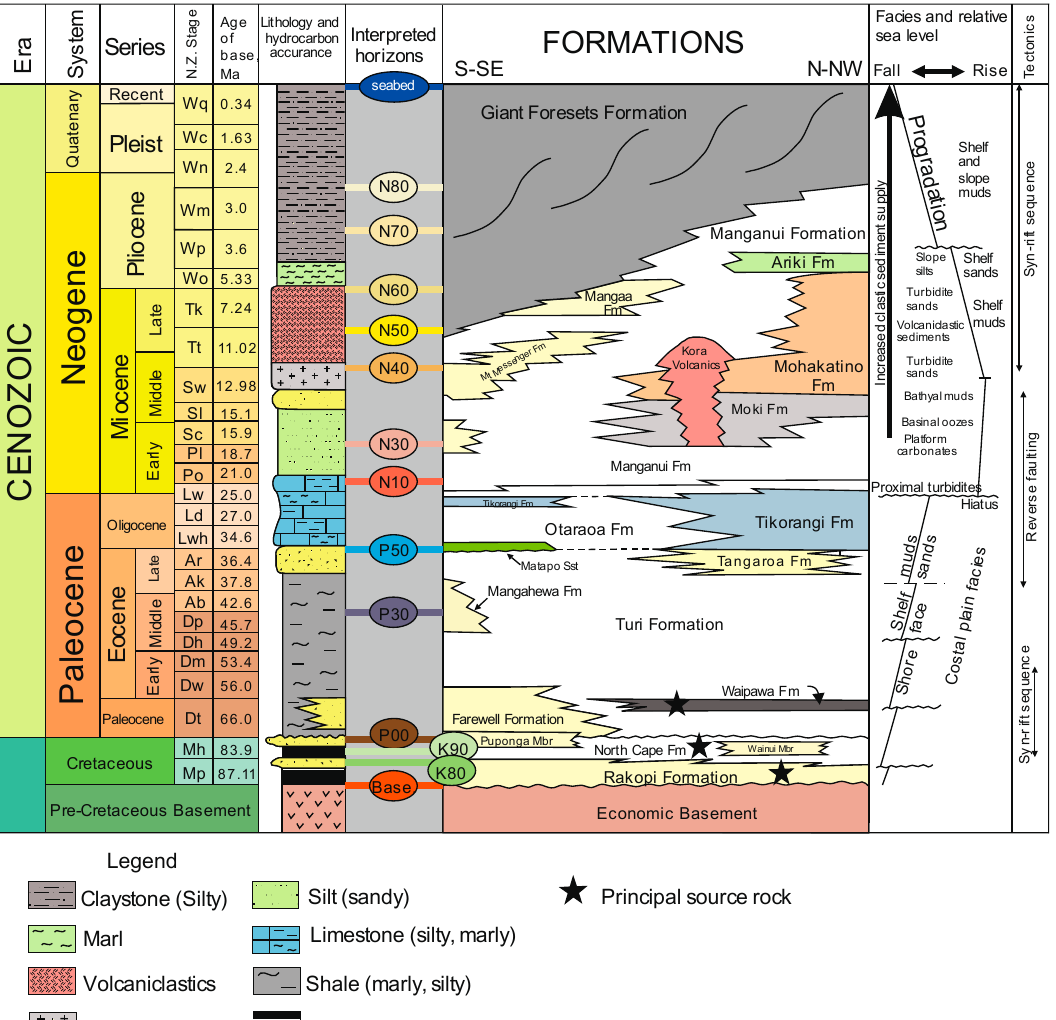
Figure 2. Cretaceous–Cenozoic stratigraphic framework for the northern Taranaki Basin and interpreted horizons from this study. Principal source rock in the area (Waipawa Formation) is marked with a star (modified after King and Trasher, [20]; Stagpoole and Funnel, [15]). Not to scale. The interpreted horizons above Cretaceous and older basement (Base), are the Late Cretaceous (horizons K80 and K90), Cretaceous-Paleogene (horizons P00–P50), Paleocene-Eocene (horizon P10), Eocene (horizon P30), Eocene-Oligocene (horizon P50), Early Miocene (horizon N10), Middle to Late Miocene (horizon N40), Base Pliocene (horizon N60), Pliocene (horizons N70–N80), Top Giant Forests (Pliocene) and the modern seafloor .